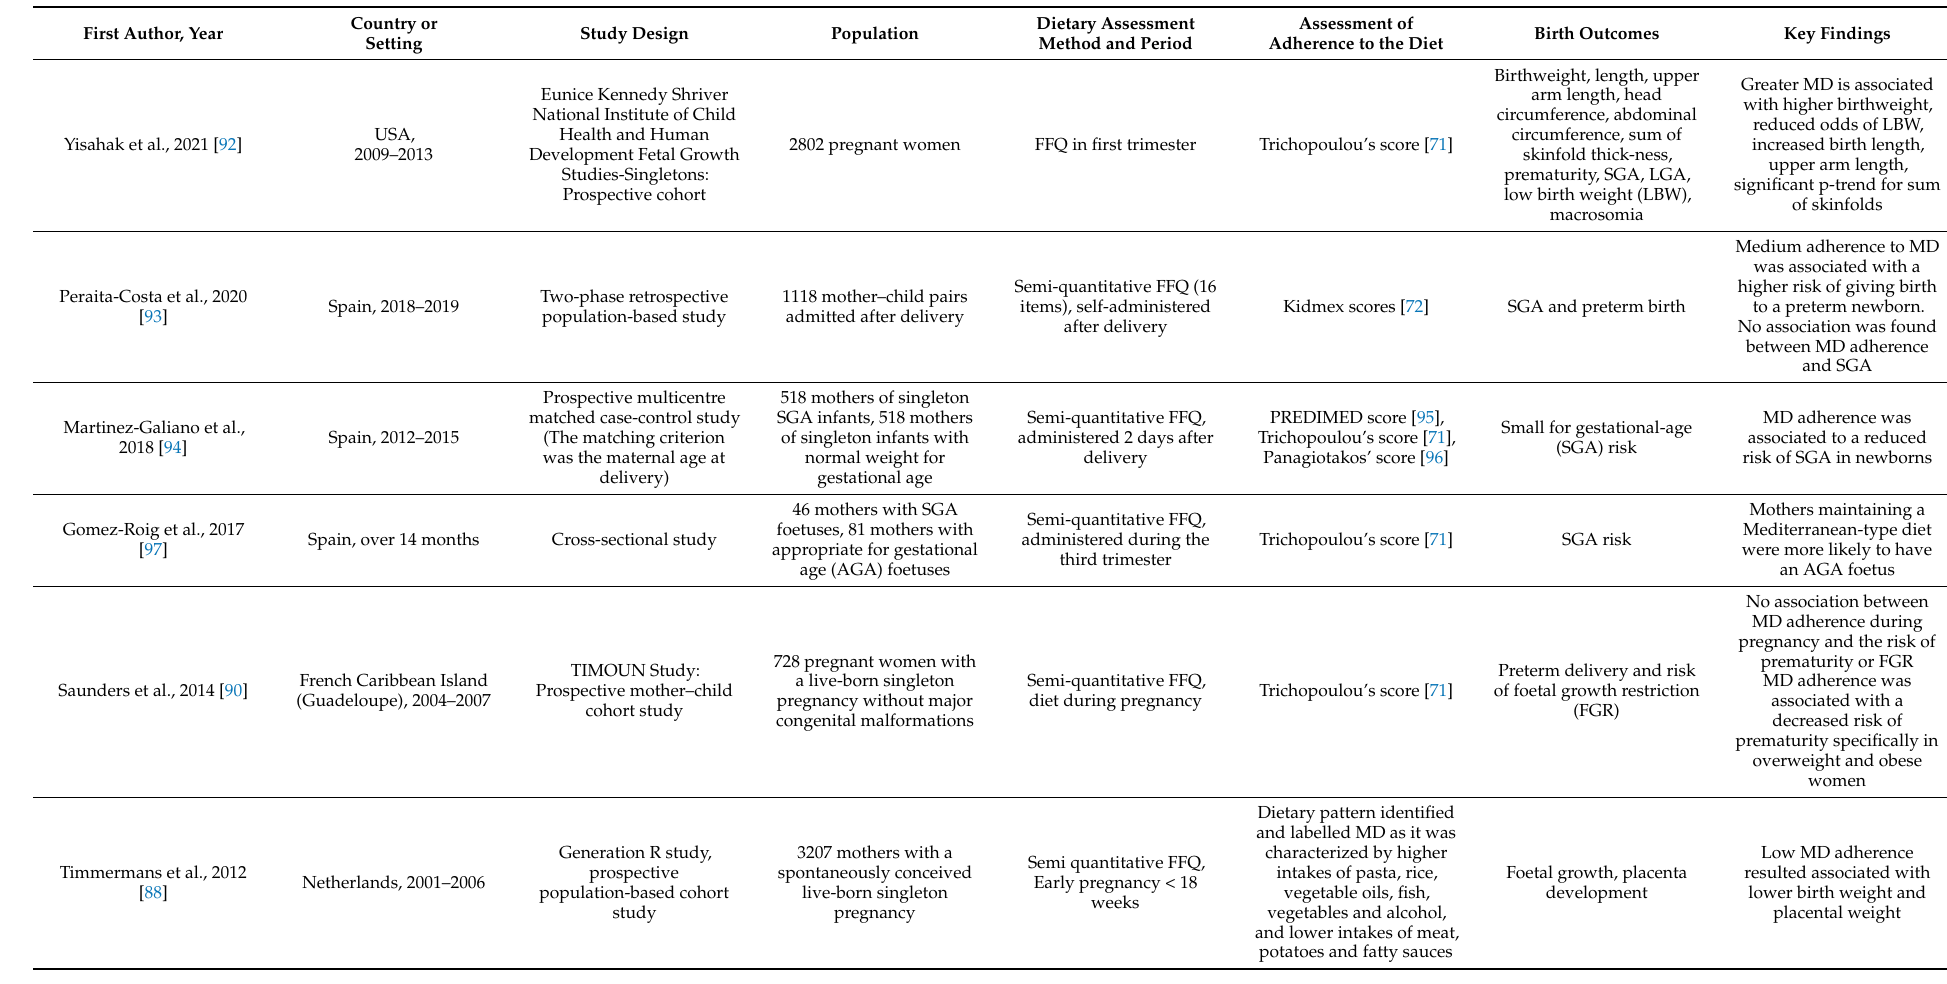
Table 3. Individual studies on the associations between maternal dietary quality determined by the Mediterranean diet score and birth